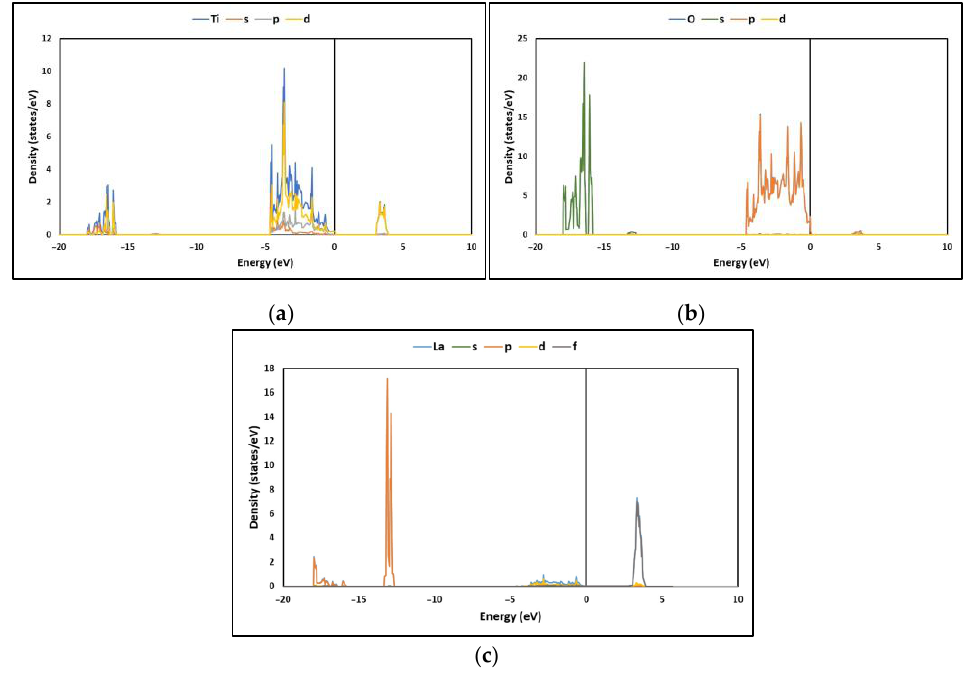
Figure 4. Partial density of states (PDOS) of ( a ) Ti, ( b ) O and ( c ) La . To confirm the ionicity of the La-O bond described in the DOS analysis, a Bader charge analysis was also performed on the La/TiO 2 structure [45]. This analysis is useful since it allows for determining the ionicity of a chemical bond from the charge transfer between the atoms that participate in said bond [46 – 48]. In the La/TiO 2 structure, the net charge of Ti (+2.5 e ) was 1.5 e less than its formal +4 e charge, while the O atom had a negative charge of − 1.3 e , which was 0.7 e less than their respective formal charges − 2 e . Finally, the net charge of La (+1.7 e ) was 1.3 e lower than its formal charge of +3 e . These results agree with those described in other studies [46]. On average, an increase of 0.21 e was observed in the atomic charge for the three surface oxygen atoms that originated new bonds with the lanthanum ion. The coordinates and the Bader’s charge analysis of the optimized TiO 2 and La/TiO 2 surfaces are provided in Table S1 (see Supplementary Materials). According to the ionization due to a possible charge transfer between the lanthanum atom and the oxygen atoms that form the chemical bond